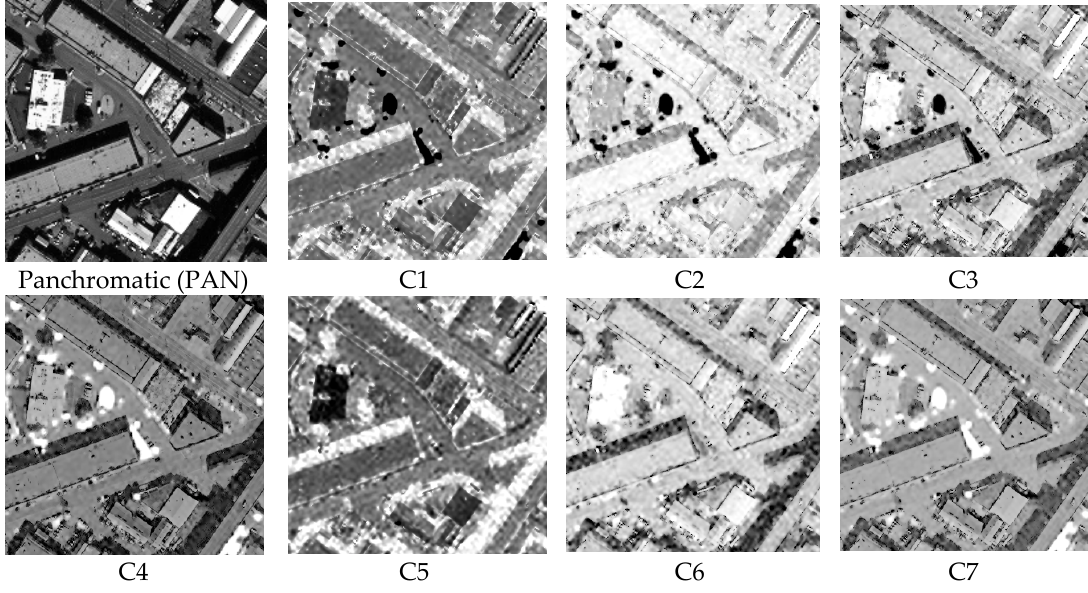
Figure 5. Normalized panchromatic and color invariant features (Equations (2)–(8)) used for shadow extraction.